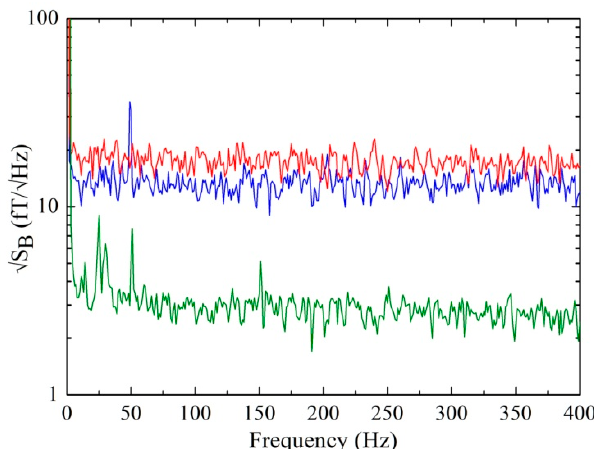
Figure 4. Spectral densities of the magnetic noise of a SQUID magnetometer . The lower (green) and top (red) spectra refer to an annealing temperature of 200 and 240 °C, respectively, while the medium (blue) spectrum corresponds to the device without annealing.